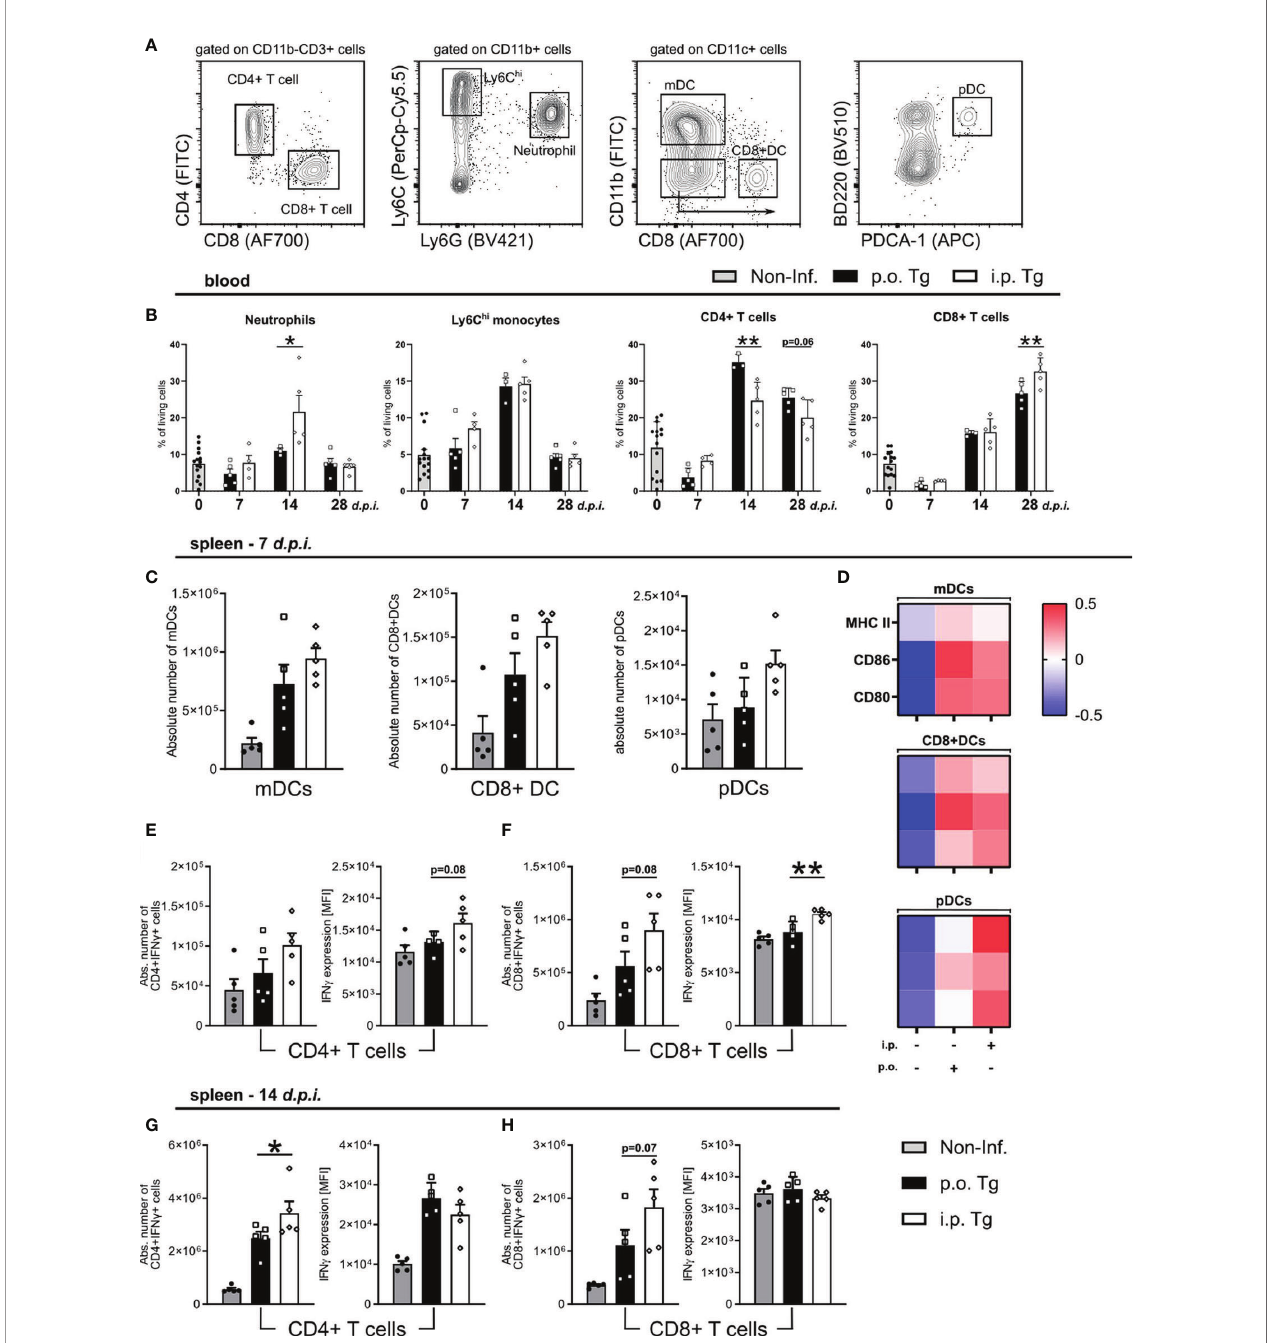
FIGURE 4 | Early T cell response in spleens of mice at day 7 and 14 post-infection. Wild-type mice were infected orally ( p.o. Tg) or intraperitoneally ( i.p. Tg) with T. gondii (two cyst, ME49). Immune cells were isolated from the blood and spleens of naïve (Non-Inf.) and T. gondii infected animals and analyzed by fl ow cytometry. (A) Representative gating strategy for myeloid and lymphoid populations (orally infected, 14 d .p.i. spleen shown). Viable single cells were chosen for further characterization of CD11b + Ly6G + Neutrophils, CD11b + Ly6G - Ly6C hi monocytes, CD11b - CD3 + CD4 + and CD11b - CD3 + CD8 + T cells. CD11c + cells were further separated into monocyte-derived DCs (mDC), CD8 + DCs and plasmacytoid DCs (pDC). Frequency or absolute number of indicated cell types in the (B) blood and (C) spleen. (D) Heatmaps show relative surface expression of MHC II, CD86, and CD80 in spleen-derived cells at day 7 p.i. Quanti fi cation of IFN g production by splenic CD4 + and CD8 + T cells in infected mice at (E, F) 7 and (G, H) 14 d .p.i. IFN g expression levels were quanti fi ed by the MFI expression of the respective fl uorochrome. Data are presented as means + SEM. Differences between groups were analyzed by one-way ANOVA followed by Tukey ’ s multiple comparisons test (*p<0.05,